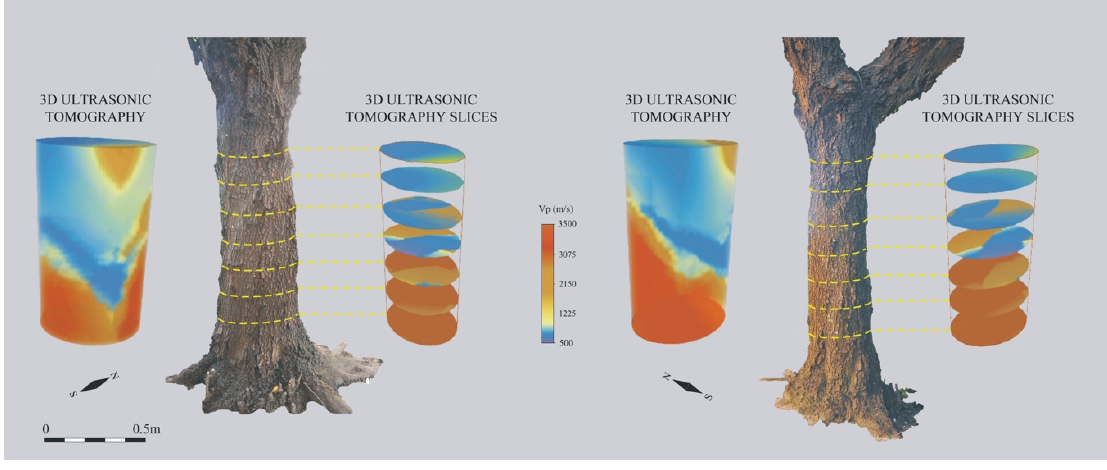
Figure 13. 3D view of tomographic slices.